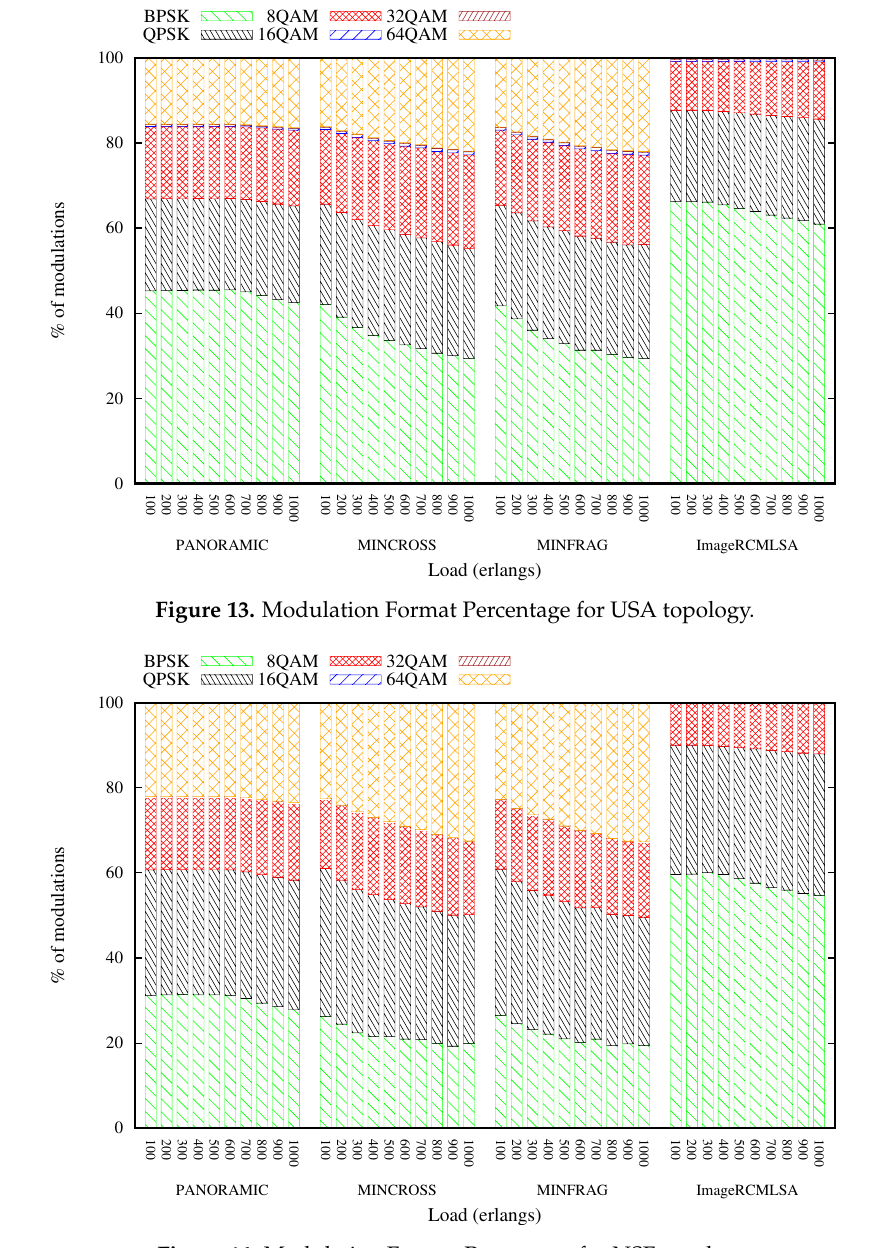
Figure 14. Modulation Format Percentage for NSF